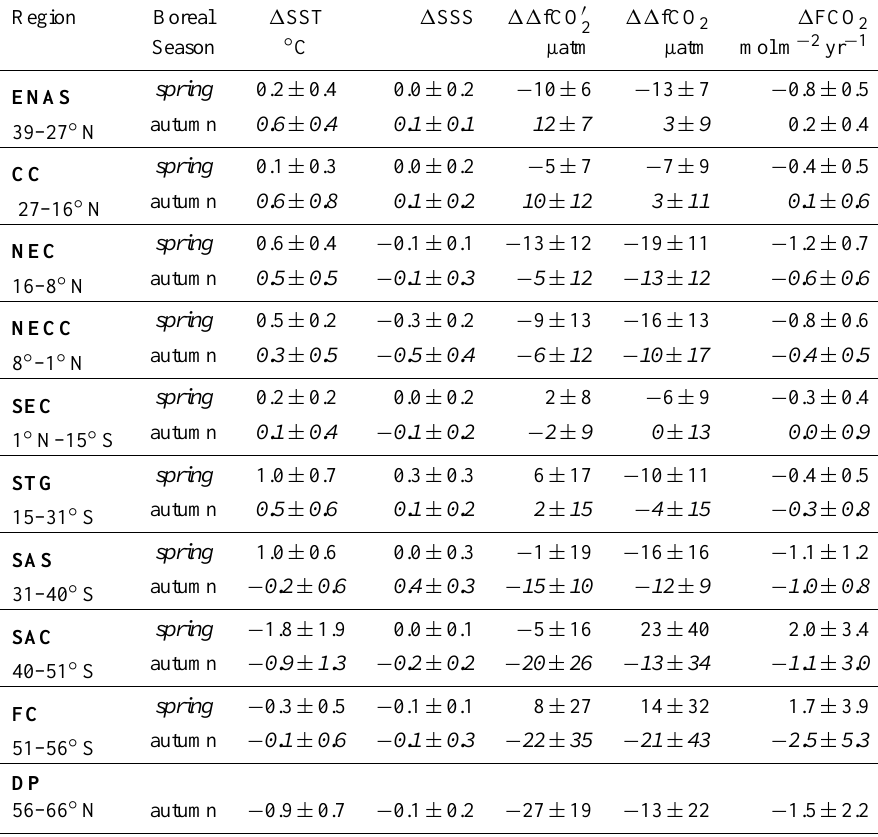
Table 4. Mean differences and standarad deviation ( µ ± σ) of SST ( 1 SST), SSS ( 1 SSS), 1f CO 2 ( 11f CO 0 the monthly averaged estimations of the Takahashi’s climatology (Takahashi et al., 2009) and these in situ measurements in the ocean waters during the FICARAM cruises (X FICARAM – X TC09 ) . 11f CO 2 was estimated correcting 11f CO 0 theoretical temperature control described by Takahashi et al. (1993). To compare the climatological F CO 2 values to our estimations, we multiplied 11f CO 2 with climatological k and S according to Eq.